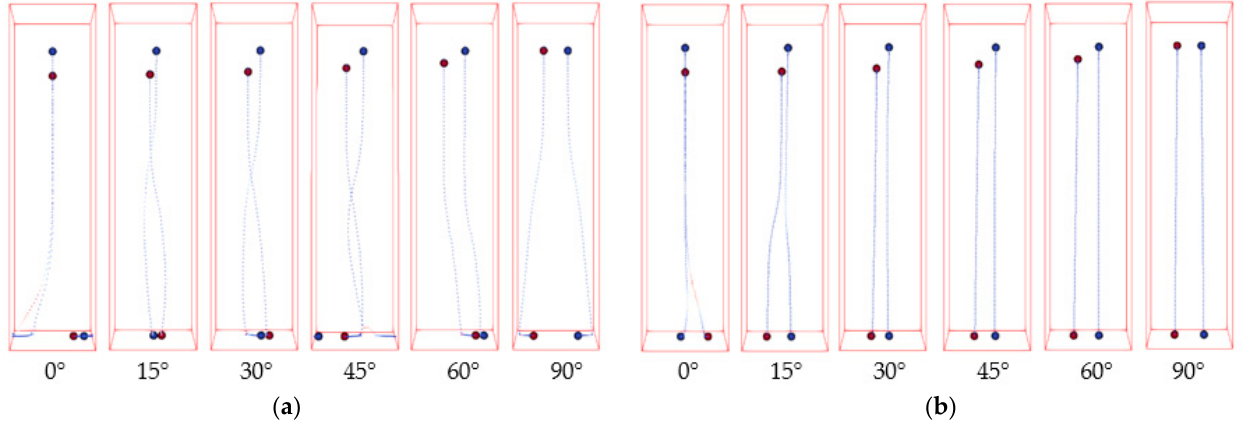
Figure 17. Particles’ trajectories at two different Reynolds numbers. ( a ) Re = 18.18; ( b ) Re =